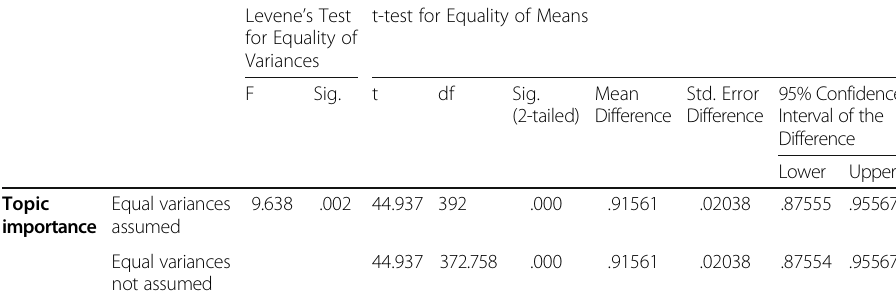
Table 12 The results of t-test to compare the results of learners ’ perception of textbook-assigned and self-selected topics regarding topic importance Levene ’ s Test t-test for Equality of Means for Equality of Variances F Sig. t df Sig. Mean Std. Error 95% Confidence (2-tailed) Difference Difference Interval of the Difference Lower Upper Topic Equal variances importance